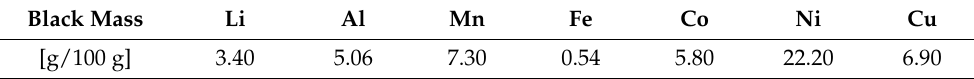
Table 2. Composition of black mass measured via